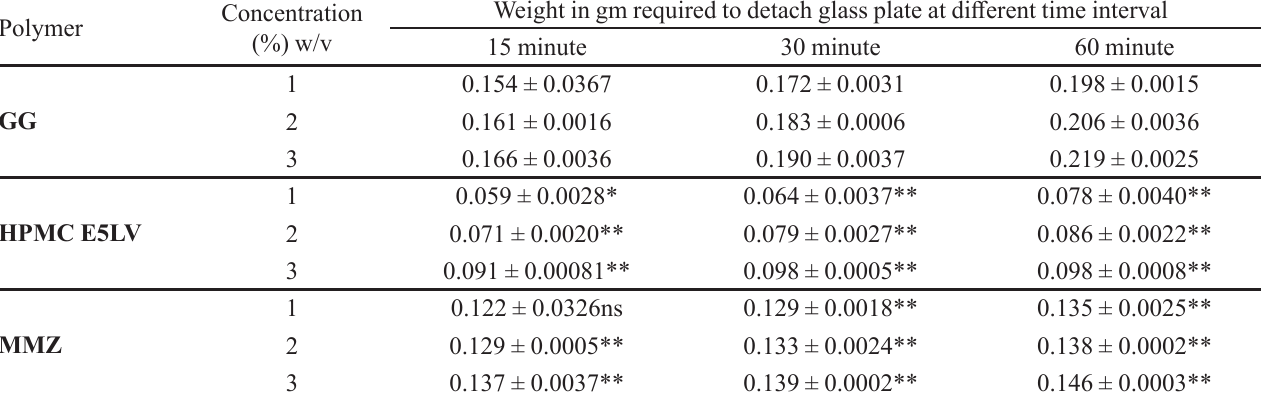
TABLE II - Shear stress (in Newton) measurement of standard (Guar Gum and HPMC E5LV) and test material (Mucilage) Polymer